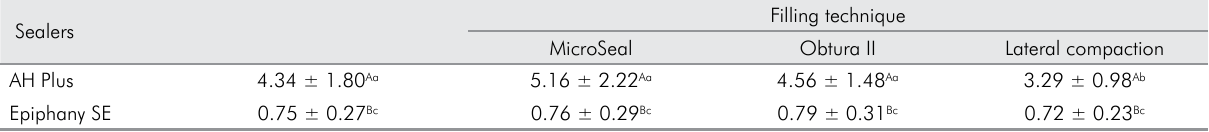
Table 1. Bond strength mean and standard deviation values (in MPa) for the displacement of the filling material from the specimens in each group during the push-out